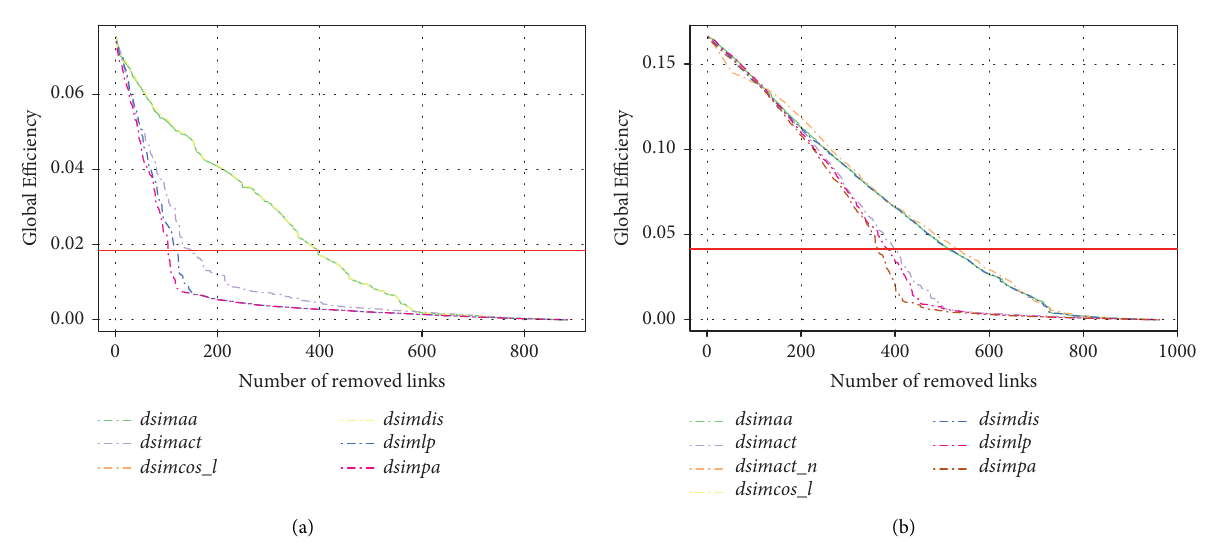
Figure 7: Variation in global efficiency when links with certain similarity characteristics are removed in Thunder Bay Transit (a) and TransAntofagasta (b)